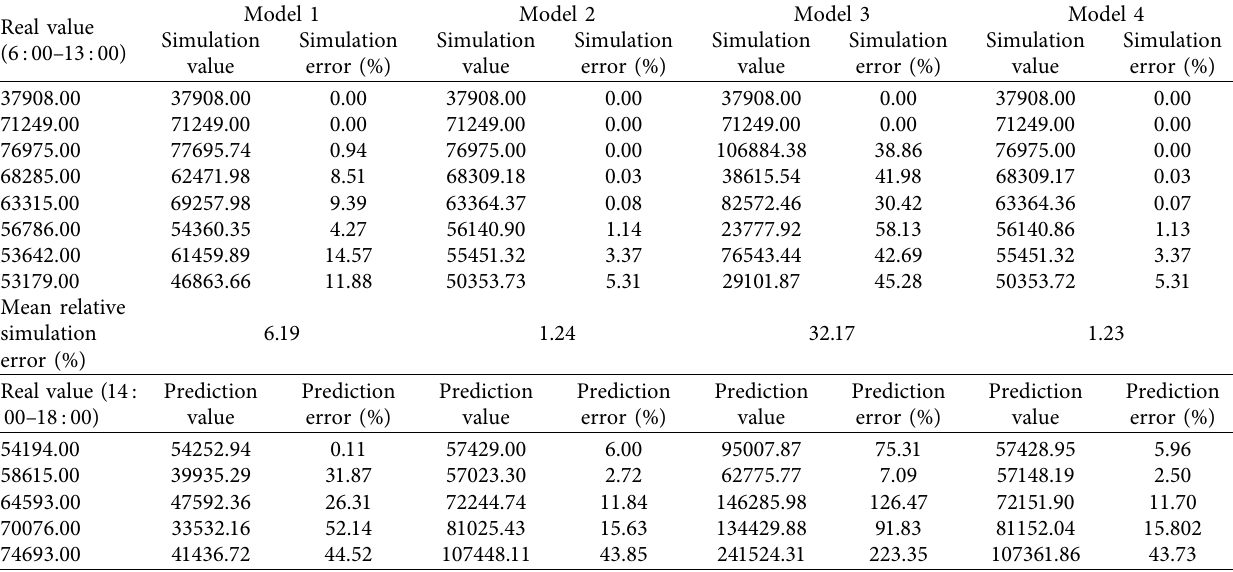
Table 5: Comparison of the simulated predictions of the four models on city trafc